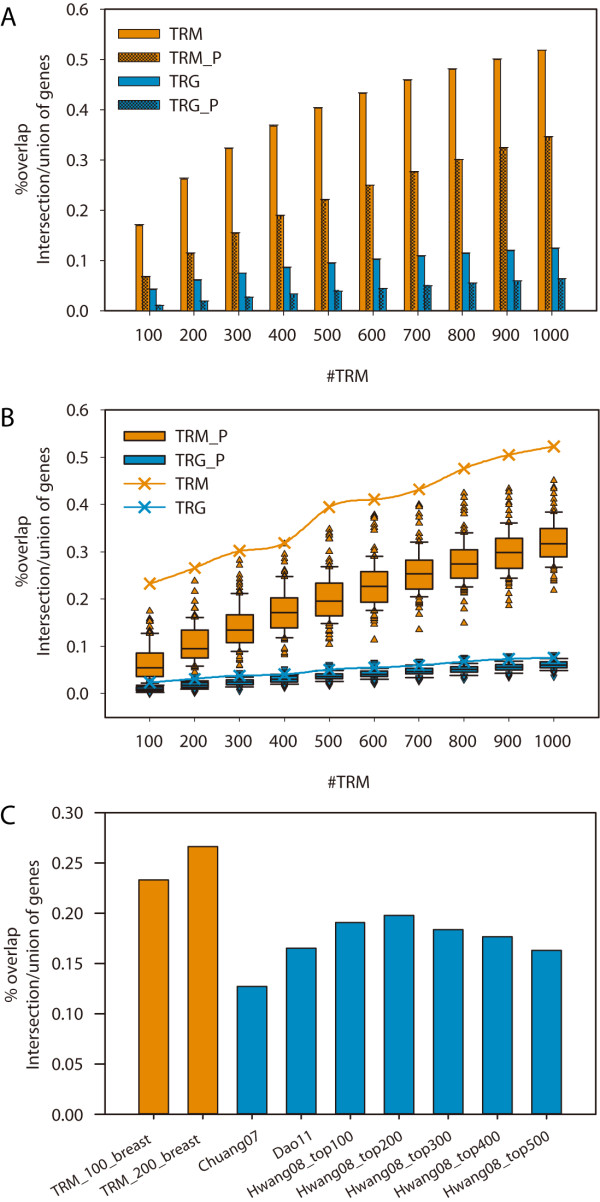
TRM reproducibility of intra- and inter- datasets. The percentage of overlapping genes is calculated as the ratio for the number of intersection and union of the genes. We compared the percentage of overlapping genes on TRM, TRG with the equal number of genes in TRM, and their corresponding permutation test controls (TRM_P and TRG_P). We performed the above comparison on (A) two randomly split halves of Lin07, (B) two datasets for the different microarray platform, van02 and wang05. We compared our overlapping percentage of inter-datasets (orange) with others methods (blue) (C).